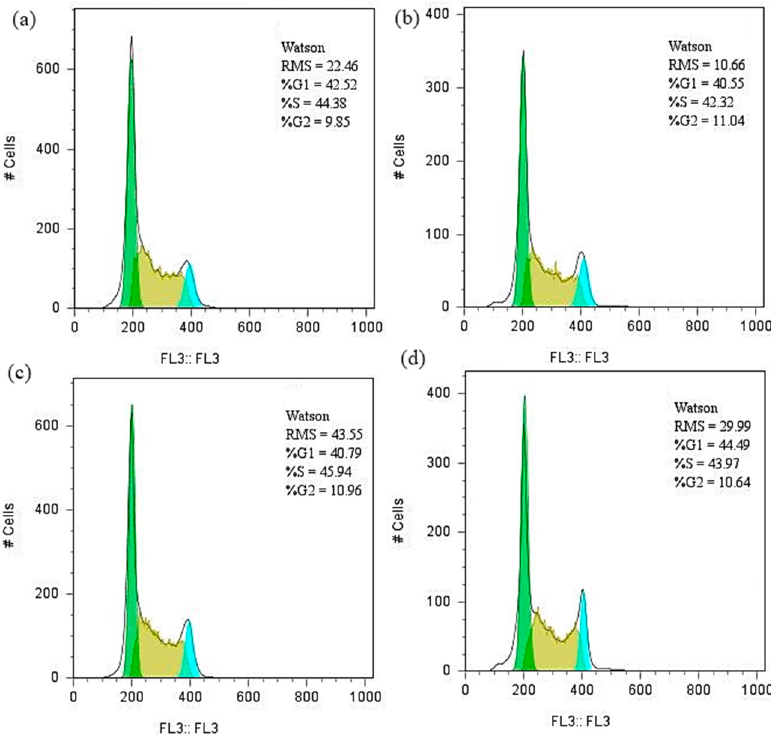
Figure 11. Cell cycle analysis with PI using flow cytometry: uniparametric DNA histograms of propidium iodide intensity (FL3). 0.05 AgHAp ( a ), 0.1 AgHAp ( b ) HAp ( c ), and MG63 (ATCC CRL1427) ( d ).